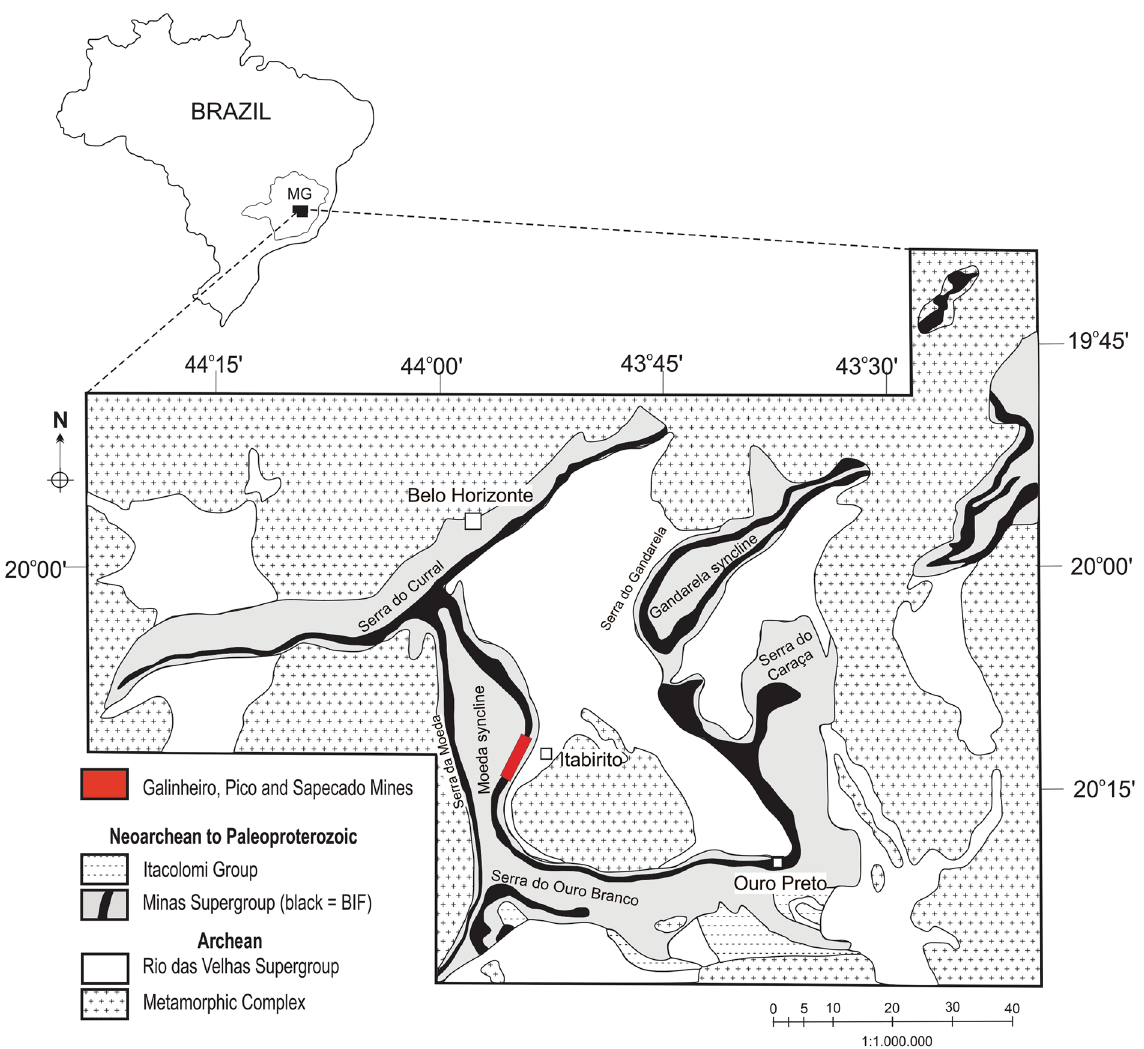
Fig. 1 Simplified geological map of the Quadrilátero Ferrífero, modified from Dorr et al. [6], showing the location of the study areas, Galin- heiro, Pico and Sapecado mines. Inset abbreviation: BIF = Banded Iron Formation; MG = Minas Gerais